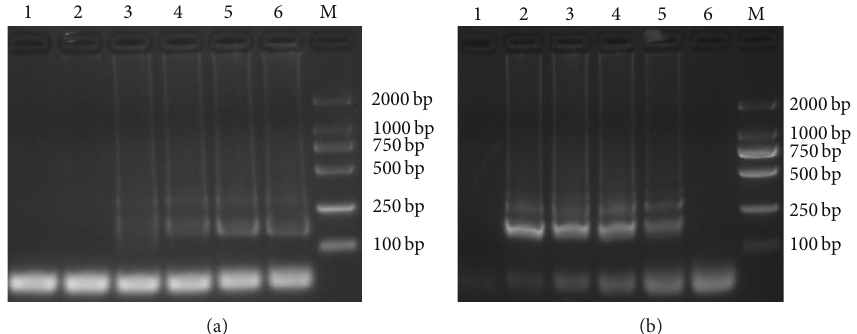
Figure 2: Optimization of the LAMP reaction conditions. (a) Reaction temperature: 1–6: 60 ∘ C, 61 ∘ C, 62 ∘ C, 63 ∘ C, 64 ∘ C, and 65 ∘ C, M: DL2000 DNA marker. (b) MgCl 2 concentration: 1–6: 0 mM, 2 mM, 4mM, 6 mM, 8mM, and 10mMMgCl 2 : M: DL2000 DNA marker.